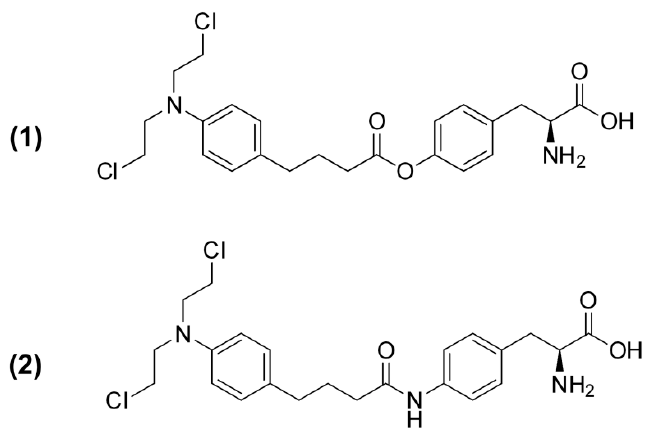
Figure 1. Structures of chlorambucil derivatives 1 and 2.